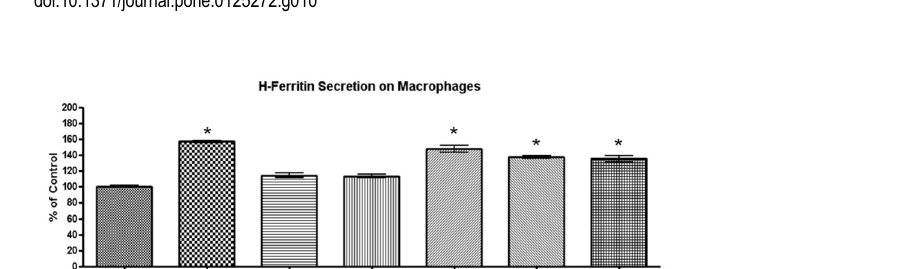
Fig 10. Ferroportin expression in Macrophages. Rat peritoneal macrophages were obtained as described in the methods. The cells were harvested after a 6-hour exposure to 0.1 mg/ml elemental iron from the different iron compounds in the presence or absence of 500nM hepcidin. The data show that exposure to all of the compounds is associated with an increase in ferroportin expression (band at 63 kDa not shown). The iron compound induced ferroportin expression was blunted by the presence of hepcidin. The expression levels were normalized to β -actin.